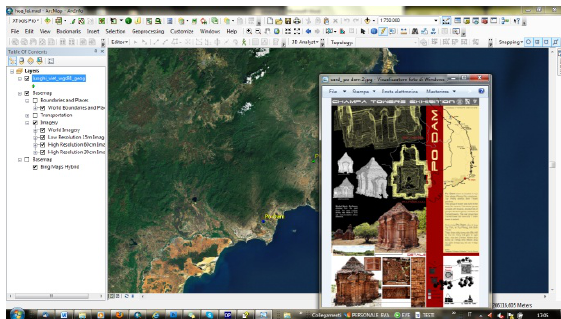
Figure 17. A description of the site by a hyperlink card in the GIS database